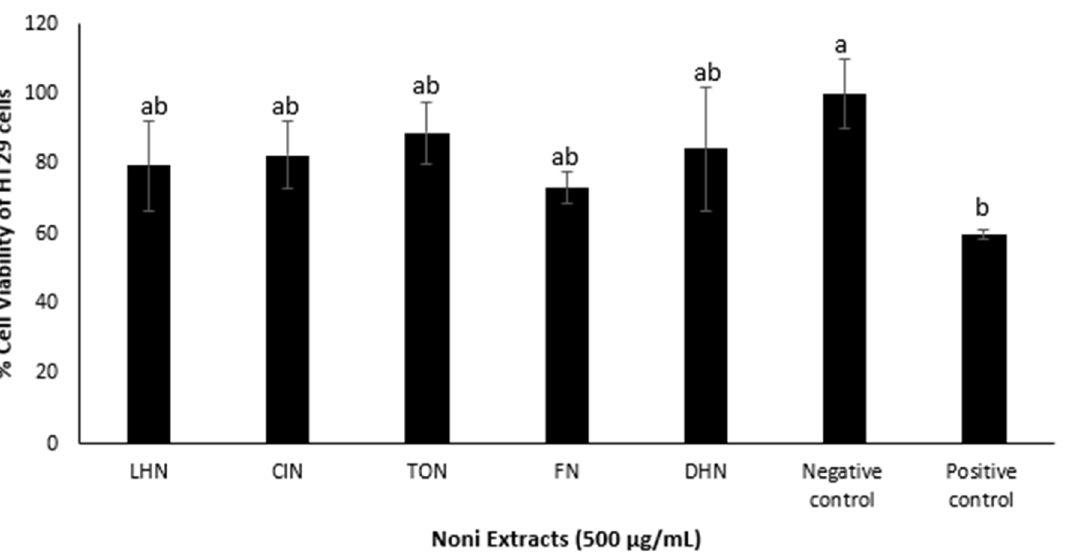
Figure 4. The percentage cell viability of HT29 cells treated with different sources Noni juice extracts at 500 µg/mL. Different letters on the bar indicate significant difference between the different sources of Noni crude extracts ( p < 0.05). Negative control: cells without treatment; positive control: cells treated with 10 µg/mL cisplatin (chemotherapy drug). Abbreviations: FN = Fijian Noni; LHN = Life Health Noni; DHN = Dynamic Health Noni; TON = Tahitian Organic Noni; CIN = Cook Island Noni.